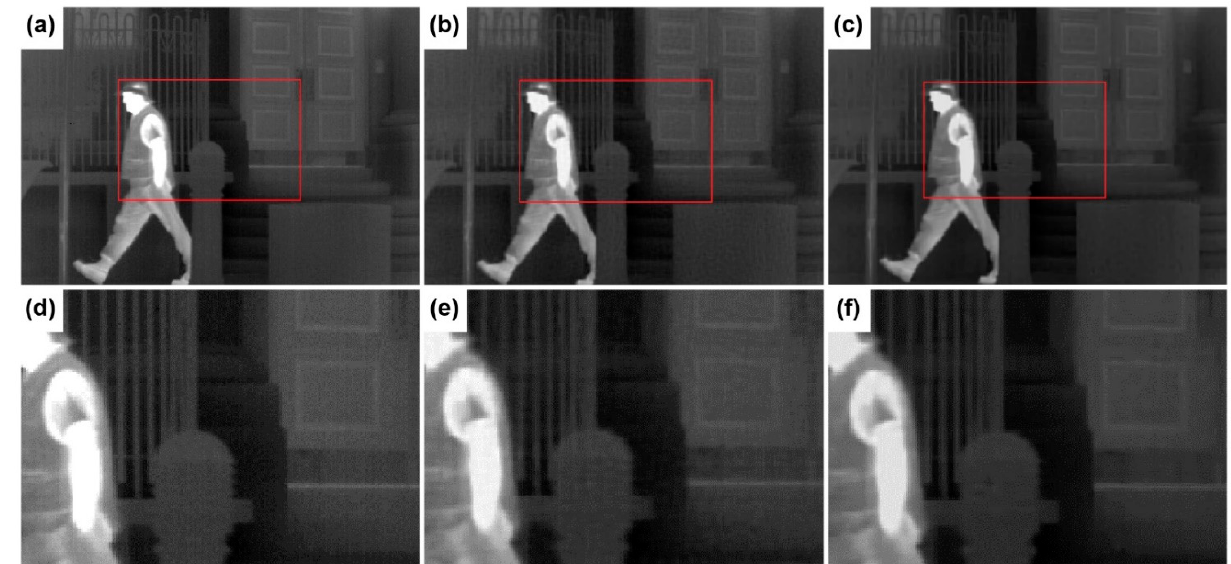
Figure 3. A comparison of the deblurring effects on a passerby image. ( a ) The original passerby image, ( b ) the image deblurred using Lp_LOGS, and ( c ) the image deblurred using Lp_HOGS. ( d – f ) The local enlarged images from the red boxes in ( a – c ), respectively.